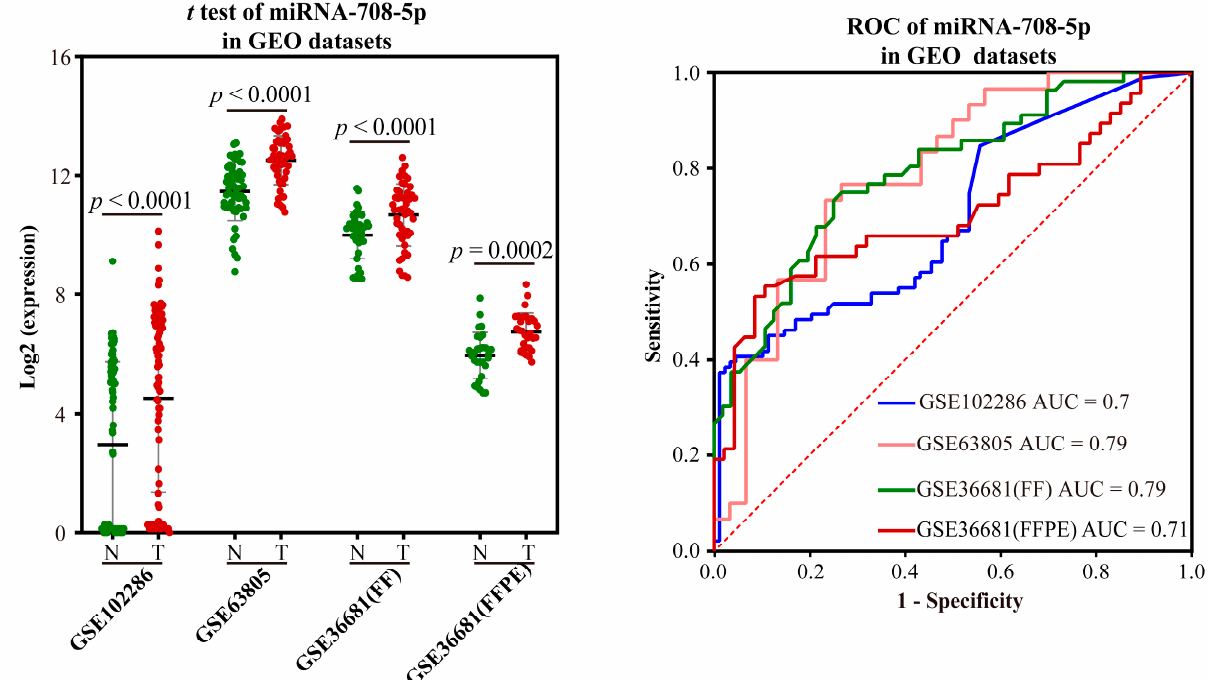
Figure 4. Validation results of miRNA markers in LUAD. FF: Fresh Frozen; FFPE: Formalin-Fixed and Paraffin-embedded. The green dot indicates the normal sample, while the red dot indicates the tumor